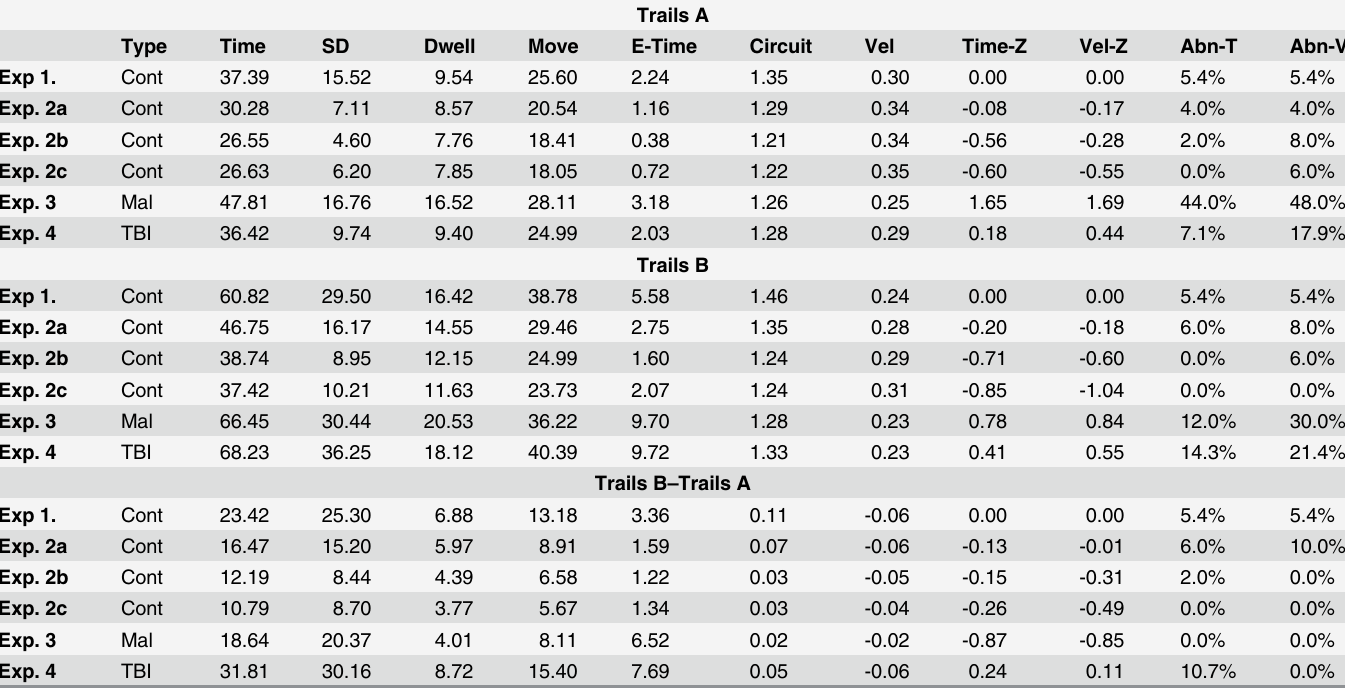
Table 4. Average values from all experiments.